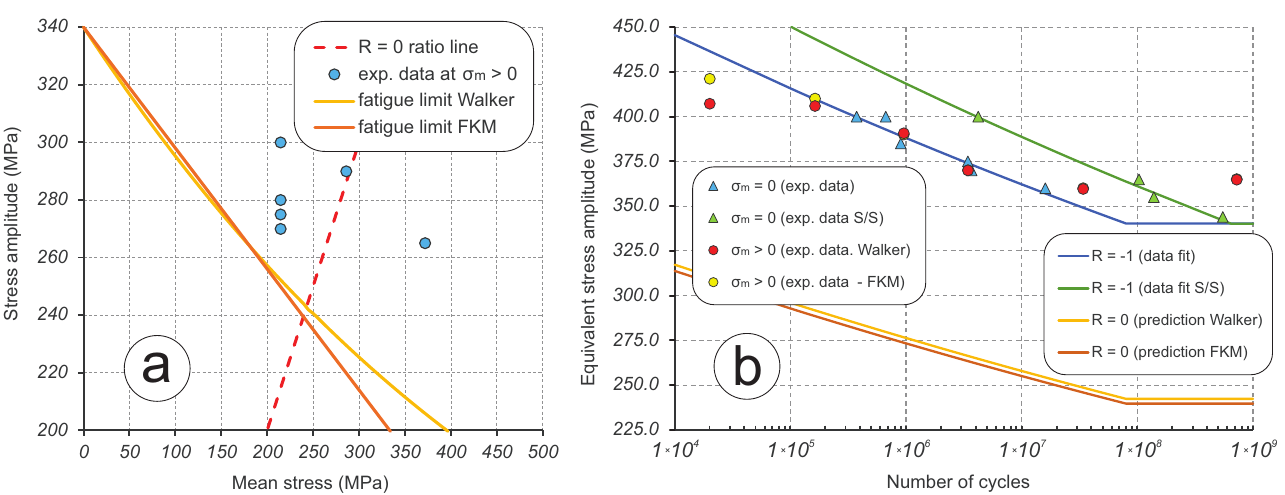
Figure 11. Investigation of the mean stress effect with Walker and FKM approaches: ( a ) Haigh diagram showing experimental data and fatigue limit extrapolation; ( b ) combined fatigue data for R = − 1 and predicted SN curves for R =